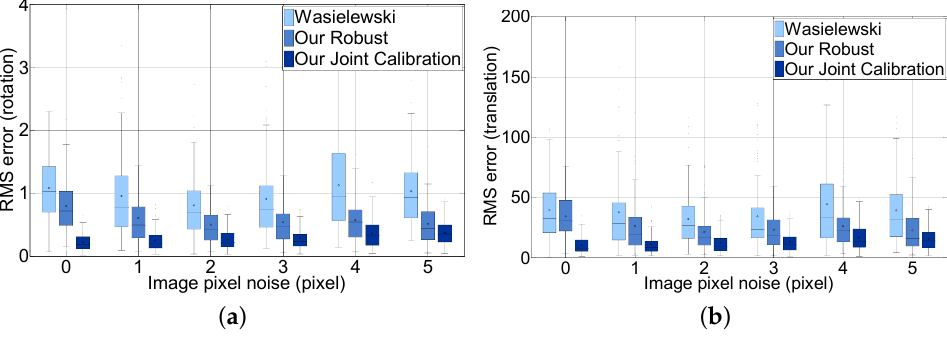
Figure 11. Effect of the image pixel noise using synthetic data: ( a ) RMS error of rotation in degrees and ( b ) RMS error of translation in millimeters; errors occur when the image pixel noise is zero, as our proposed algorithms uses pixel distance between the reprojected LiDAR feature and image. The error is dependent on the angular resolution and the distance to the target